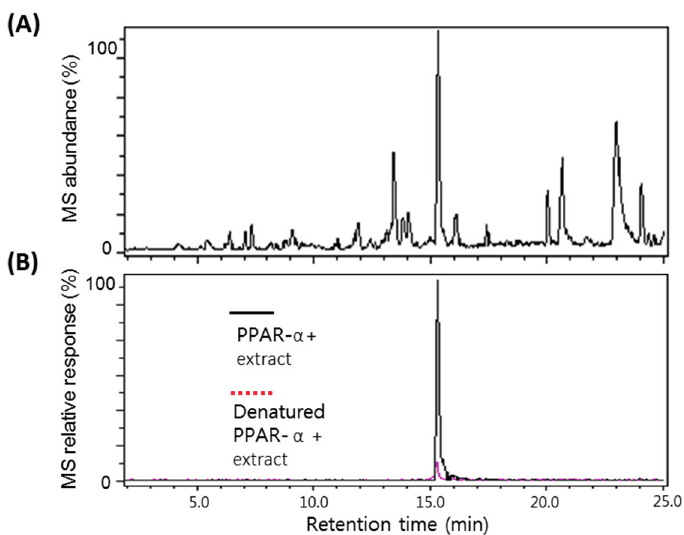
Figure 2. LC-MS chromatograms of an Artemisia argyi methanol extract ( A ) and detection of a positive compound ( B ) as a PPAR α ligand using ultrafiltration LC-MS. MetaboliteDetect at a setting of greater than threefold enhanced signal and less than 0.05 m / z difference automatically detected a positive compound in the LC-MS chromatograms of the extract.